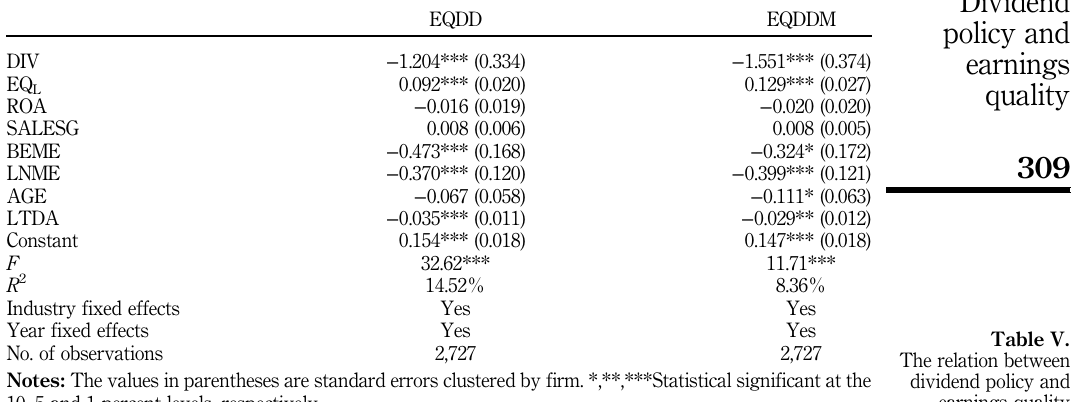
Table V. The relation between dividend policy and earnings quality